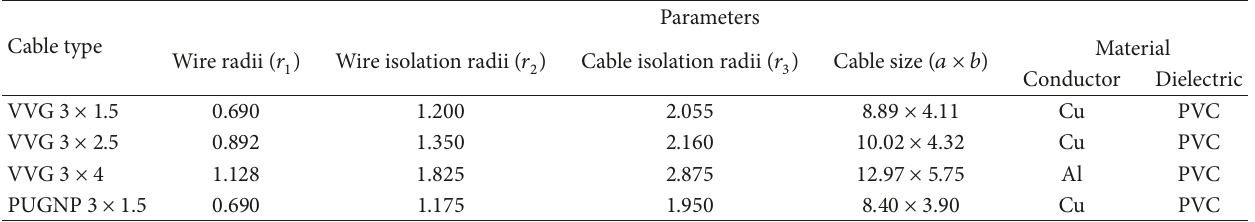
Table 4: Geometrical (mm) and material parameters of cables with air gaps.